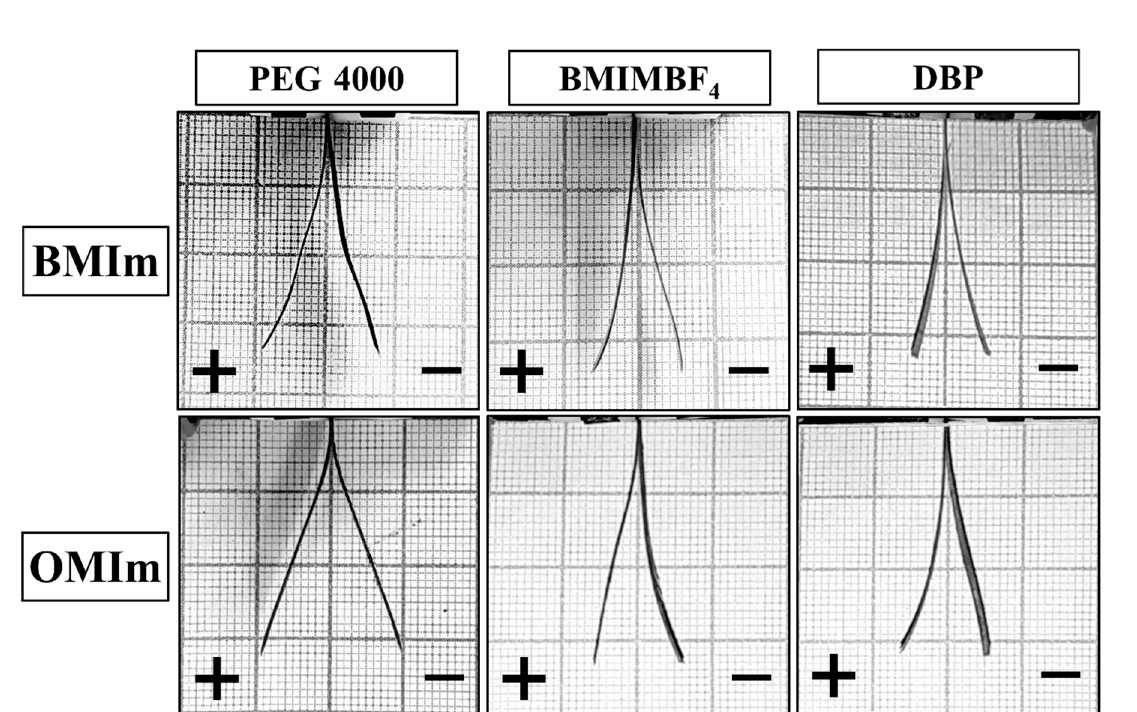
Figure 7. Peak-to-peak deformation.